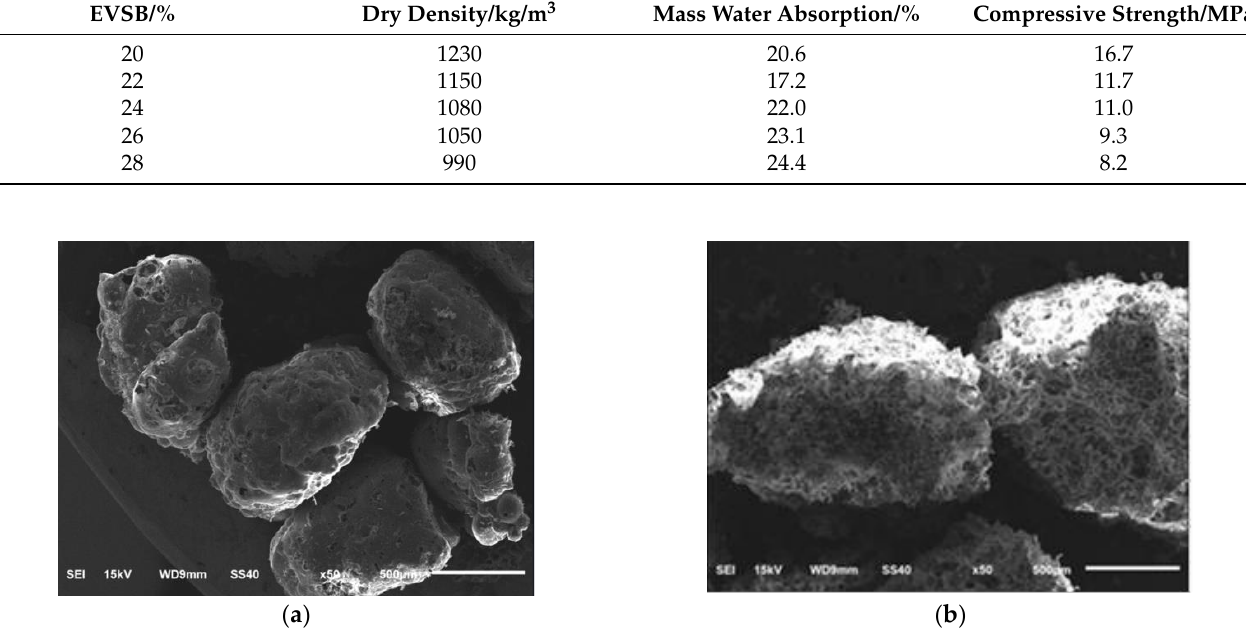
Figure 3. Comparison of scanning electron microscope images; ( a ) EVSB; ( b ) expanded perlite.